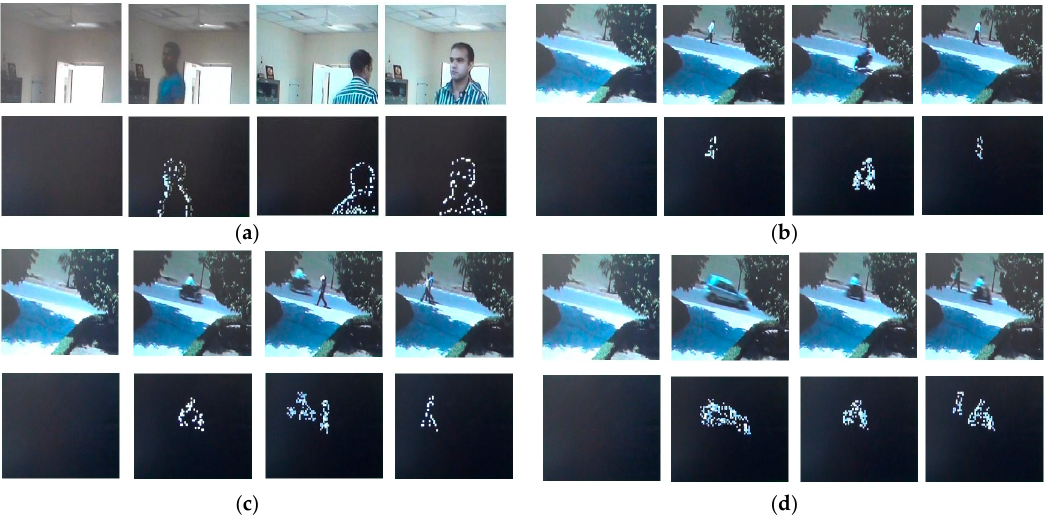
Figure 23 ( a )–( d ): Moving objects in video scene and corresponding motion detected outputs for pseudo-stationary background scenarios.